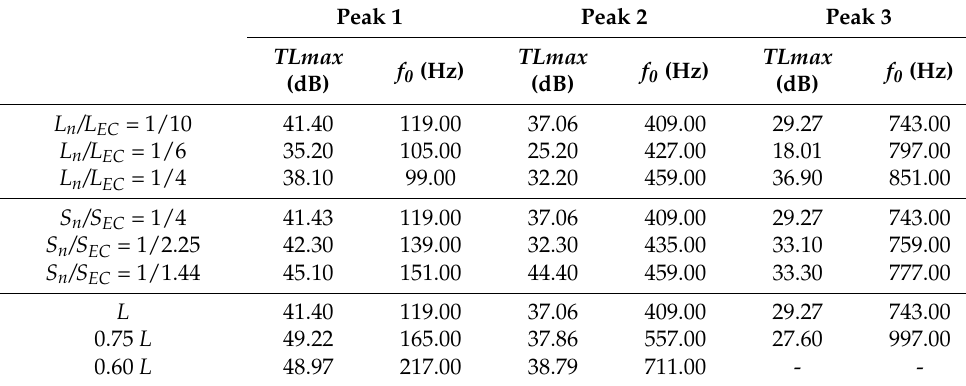
Figure 9. Comparison of transmission loss with respect to different lengths of the ITEC. Table 5. Summary of the transmission loss peak and the resonance frequency of ITEC with different geometric parameters.